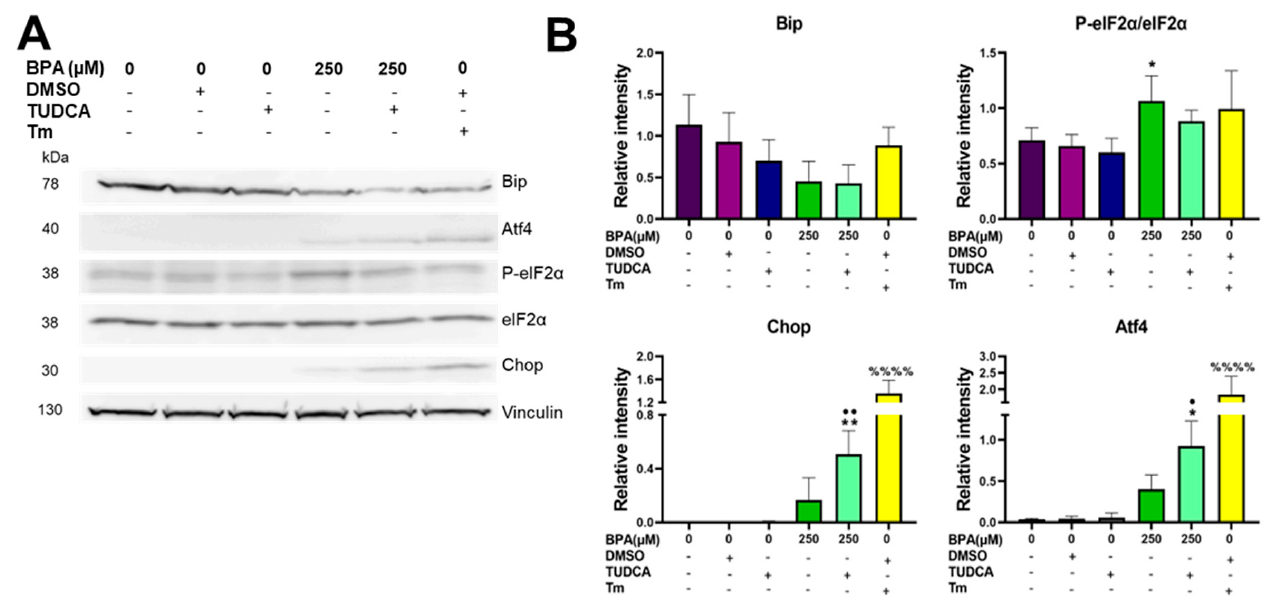
Figure 6. The UPR branch Perk is activated when co-treating cells with 250 µM BPA and 250 µM TUDCA. ( A ) MIN6 cells were treated for 8 h with BPA, TUDCA, DMSO and 5 µg/m Tm. Whole-cell lysates were analyzed by Western blot for Bip, Atf4, P-eIF2 α , total eIF2 α , Chop and Vinculin. ( B ) Graphs depict quantifications of the immunoblots. Vinculin was used as a normalizer. * p < 0.05, ** p < 0.005, compared to vehicle; %%%% p < 0.0001 compared to DMSO; • p < 0.05, •• p < 0.005 compared to TUDCA, based on One way ANOVA. Graphs represent mean ± SD.